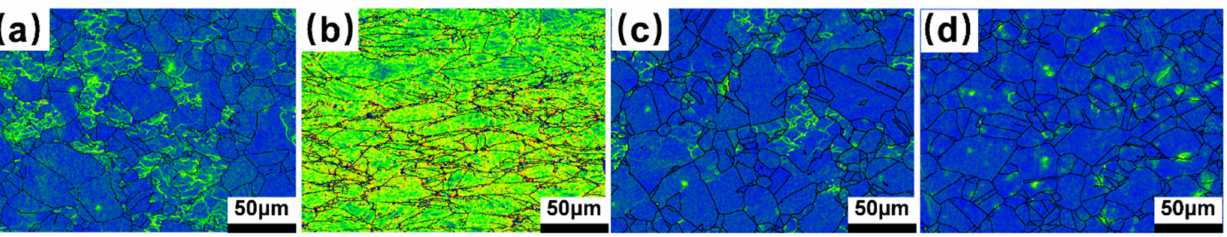
Figure 11. EBSD maps of KAM deformed at ( a ) 850 ◦ C and 0.14 s − 1 , ( b ) 850 ◦ C and 0.17 s − 1 , ( c ) 1150 ◦ C and 0.14 s − 1 , and ( d ) 1150 ◦ C and 0.14 s − 1 .